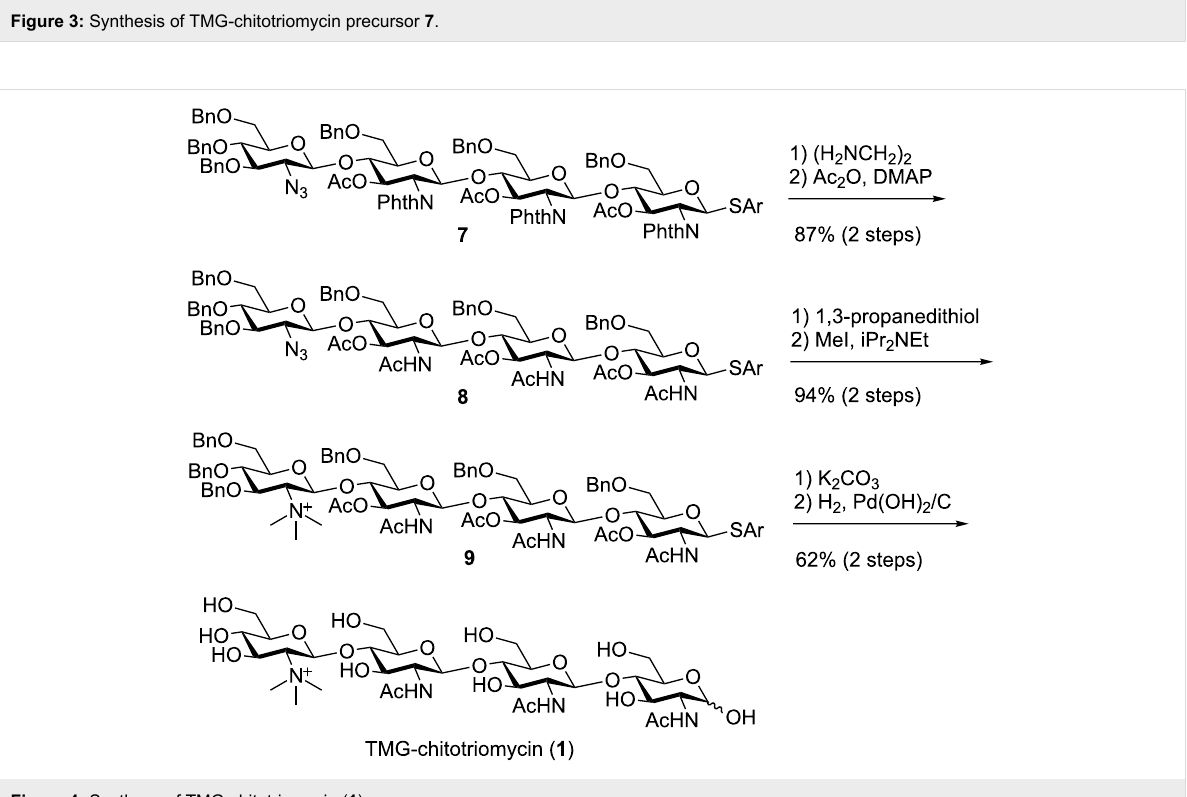
Figure 4: Synthess of TMG-chitotriomycin ( 1